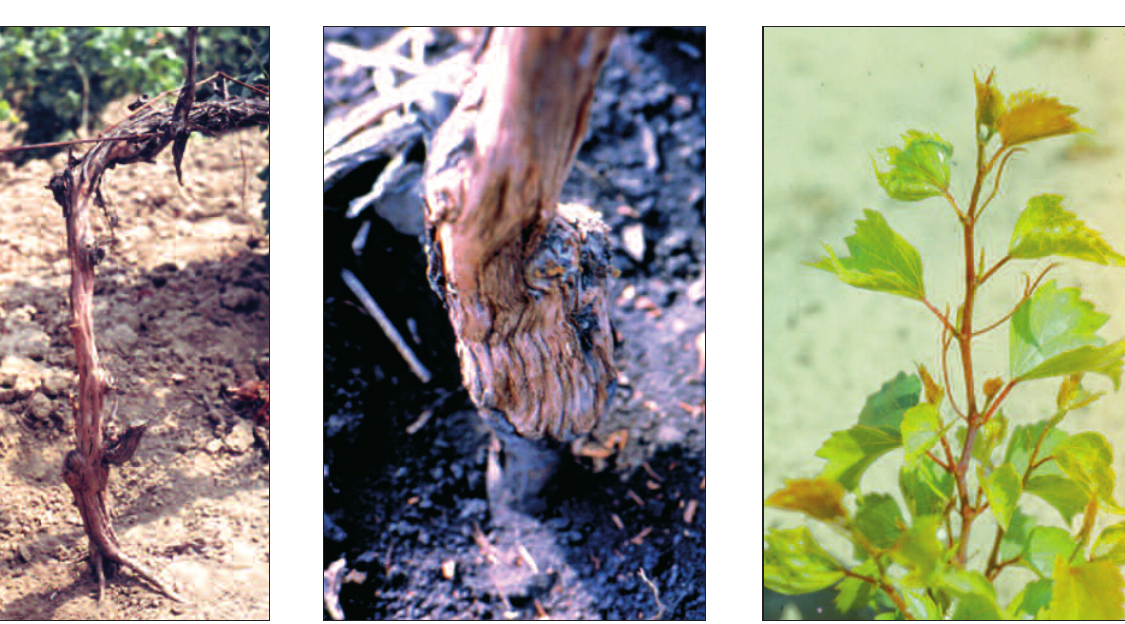
Figure 13. Typical Rugose wood (RW) symptoms on the died ownrooted stok of a susceptible Vitis vinifera variety